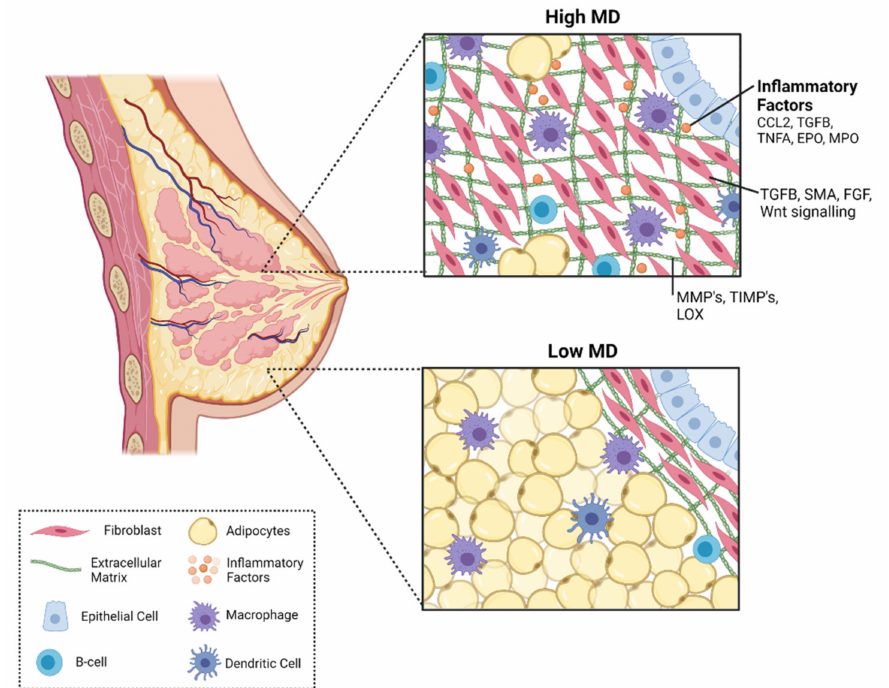
Figure 2. Biological mechanisms that are likely to contribute to high mammographic density. Interac- tions between epithelium, stroma, the extracellular matrix, and immune signalling may contribute to elevated mammographic density. Figure created using Biorender.com (Toronto,